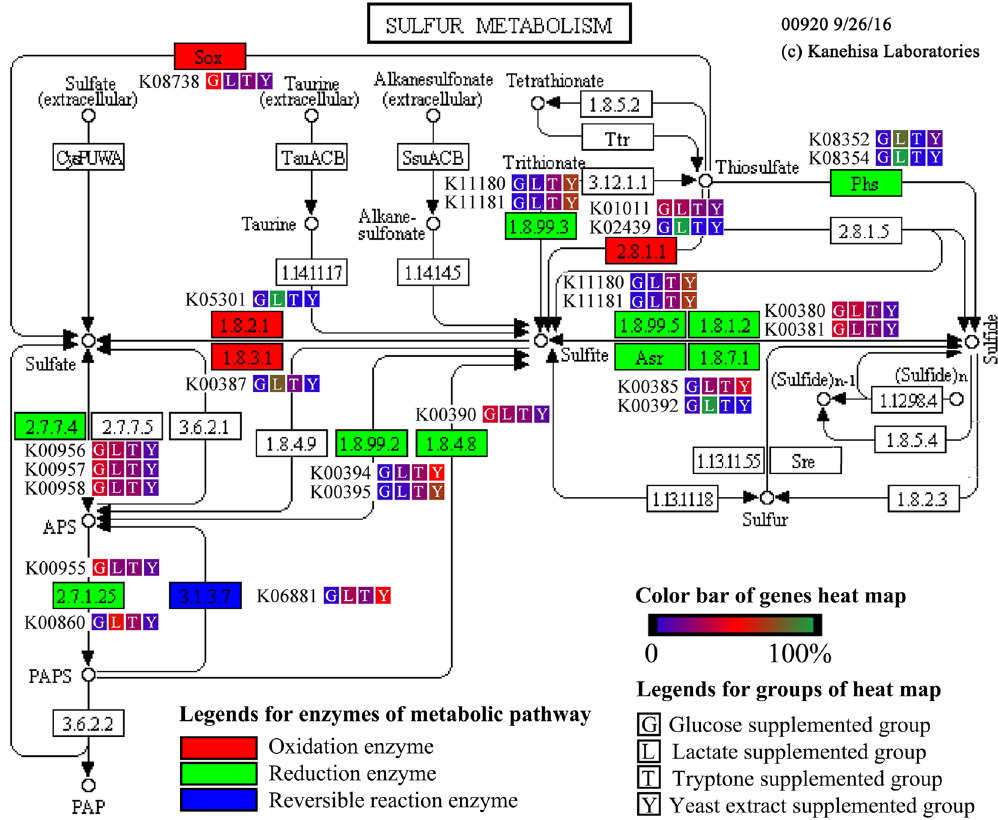
Figure 5. Differences in the sulfur metabolic pathway in the different groups, sulfur metabolic pathway is obtained by